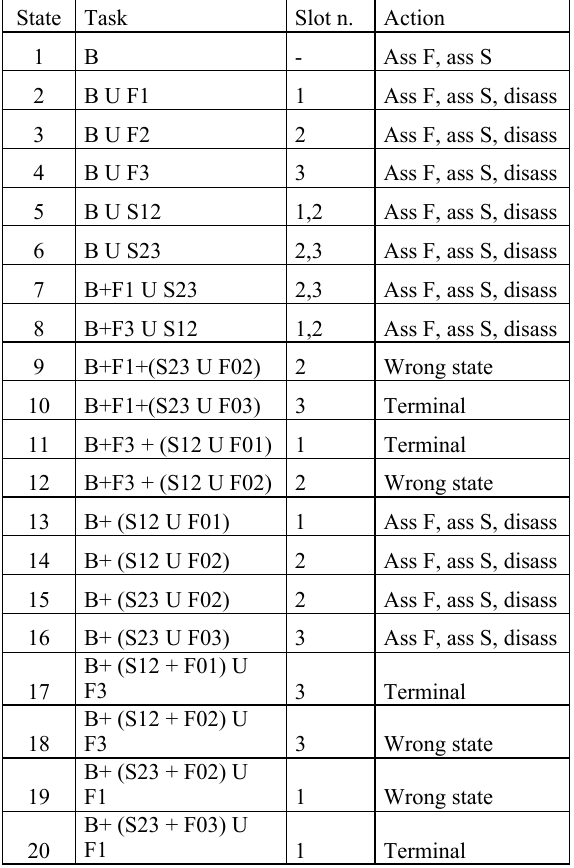
Table 1. State list: feasible assembly tasks State Task Slot n.